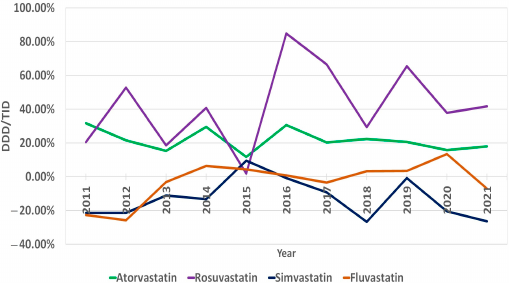
Figure 4. Annual percentage change in statin sales according to types of statins.